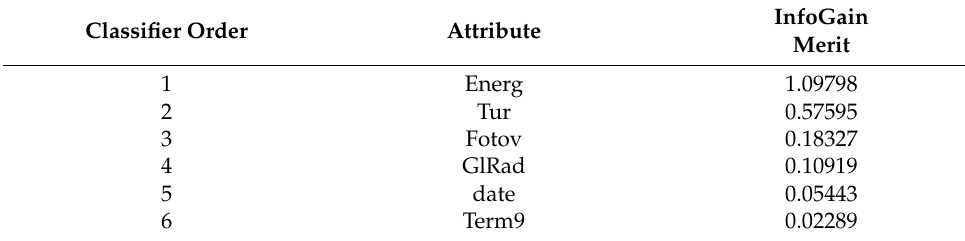
Table 8. Main attributes InfoGain